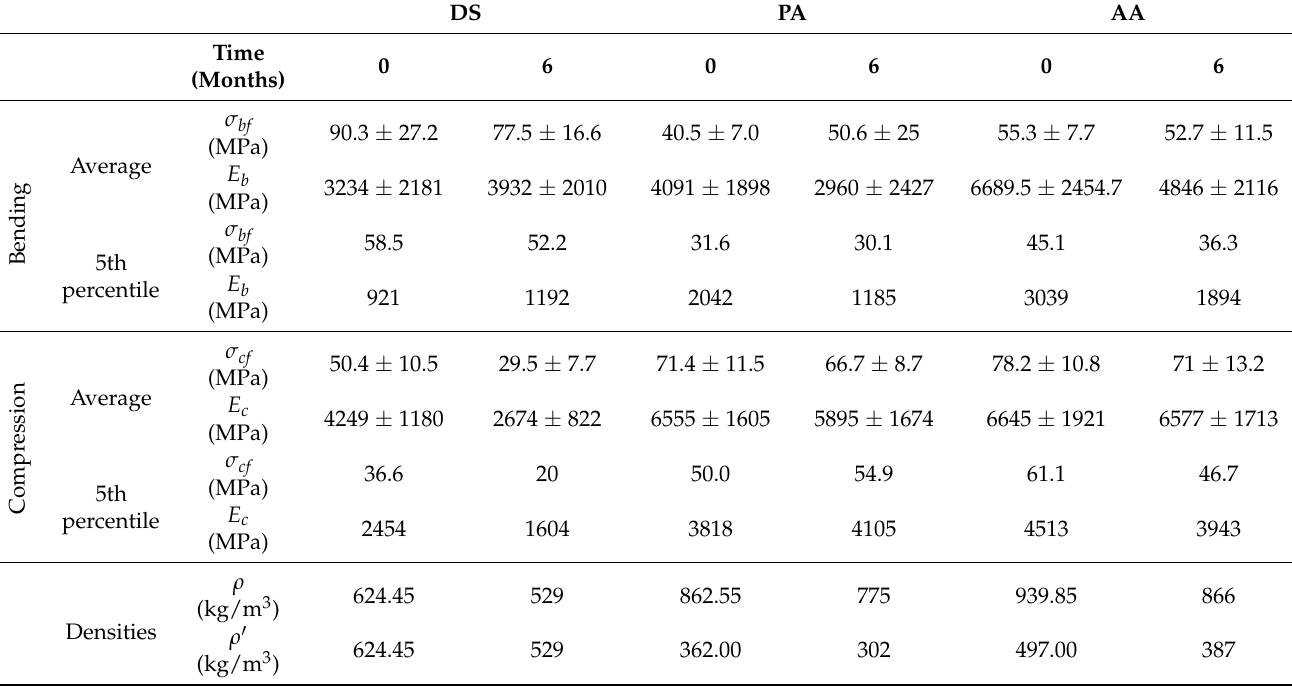
Table 6. Mechanical properties and density of DS, PA, and AA. Initial values and values after 6 months weathering are